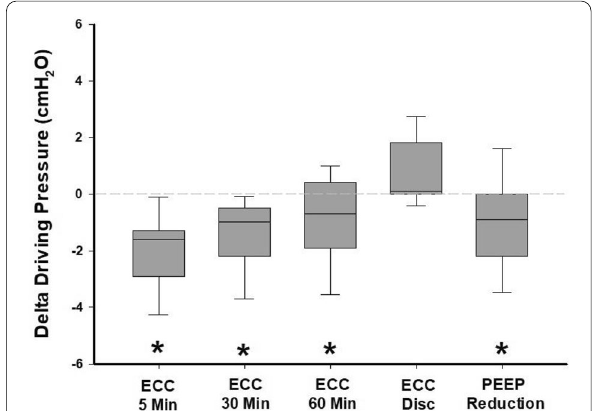
Fig. 1 Delta Driving Pressure from Baseline. N 11. Variation in = driving pressure (timepoint driving pressure—baseline driving pressure) over the study. Data are represented by box plots and are expressed in cmH 2 O. The horizontal dashed line represents baseline. ECC external chest-wall compression, ECC Disc ECC discontinuation. * P < 0.05 of absolute values of different timepoints vs.